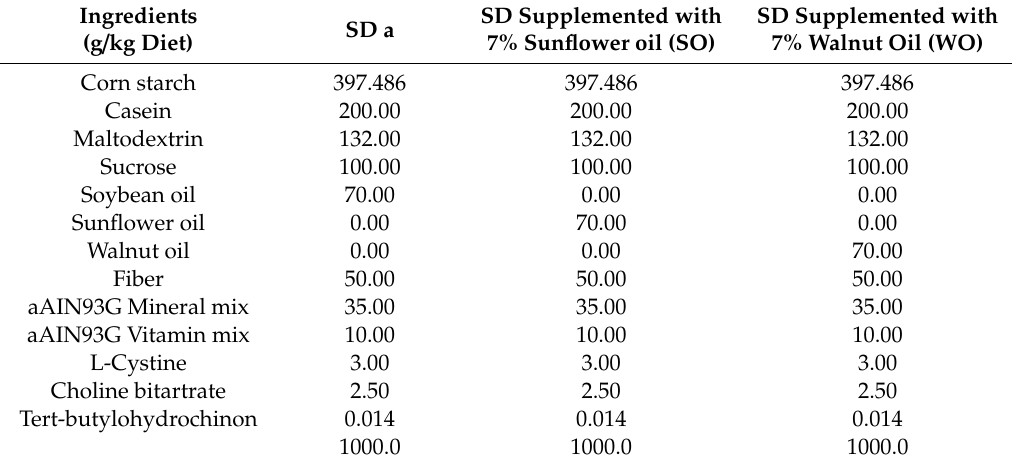
Table A1. Composition of diets that were included in the